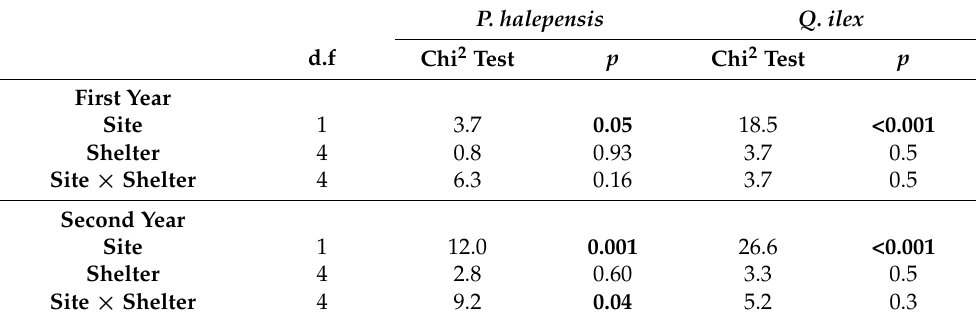
Table 2. Wald test analysis of factor significance of the logistic model of survival evaluated at the end of the first (November 2010) and second (November 2011) years after planting. Significant effects are highlighted in